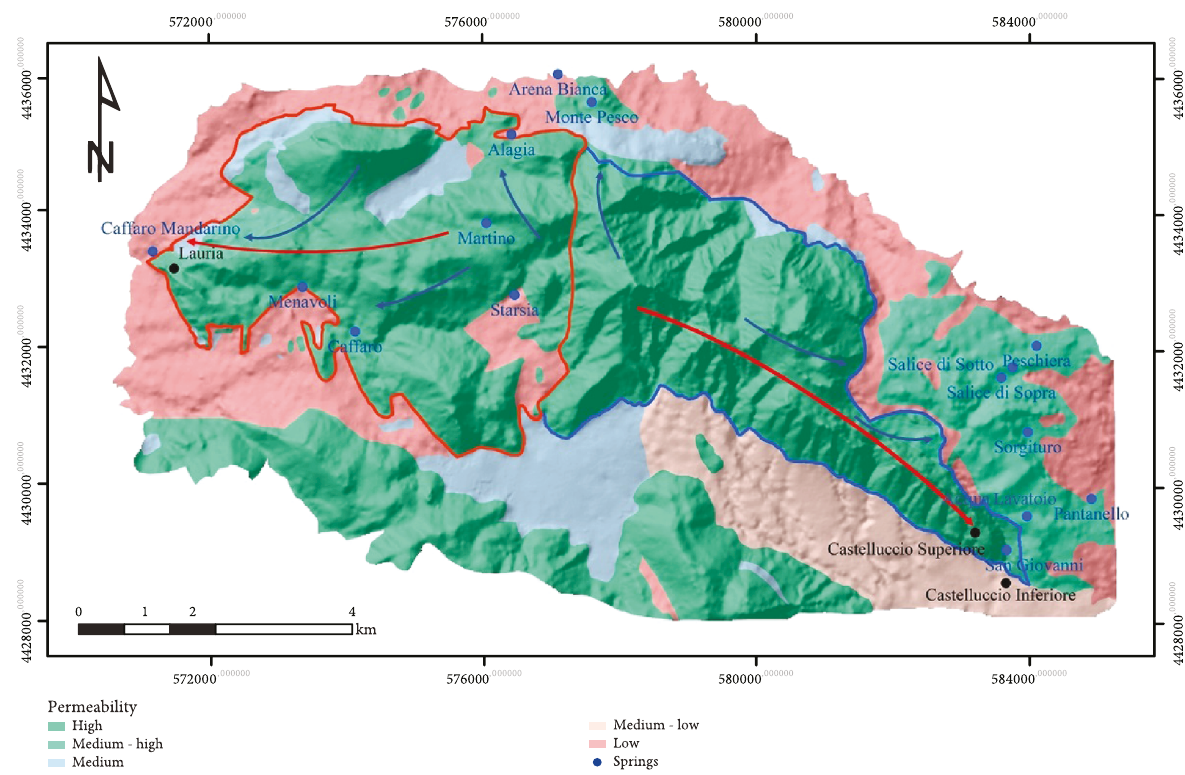
Figure 3: Hydrogeological map showing Lauria Aquifer (red line) and La Spina-Zaccana Mounts Aquifer (blue line) with relative permeability classes, main groundwater fl ow directions (red arrows and blue arrows represent, respectively, deep and shallow groundwater fl ow pathways), springs, and main urban areas (black